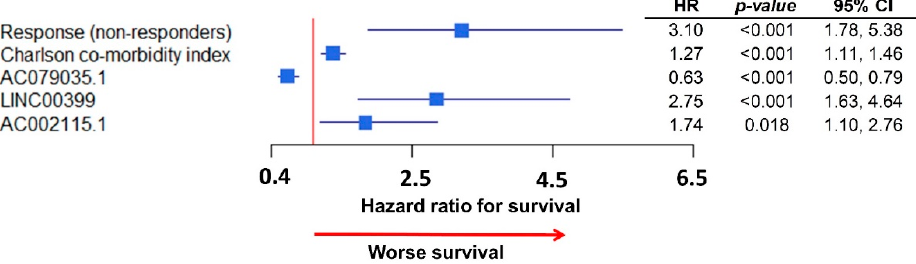
Figure 4. Forest plot of the integrative multivariate model with clinical data and lncRNA expressions: Response to chemotherapy remained highly associated (HR: 3.1) with survival; LINC00399 was the lncRNA with highest association with survival (HR: 2.75).